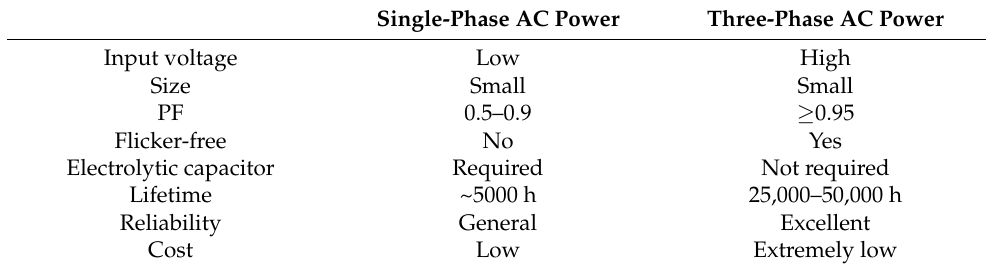
Table 1. Single-phase AC power VS three-phase AC power for linear GaN LED